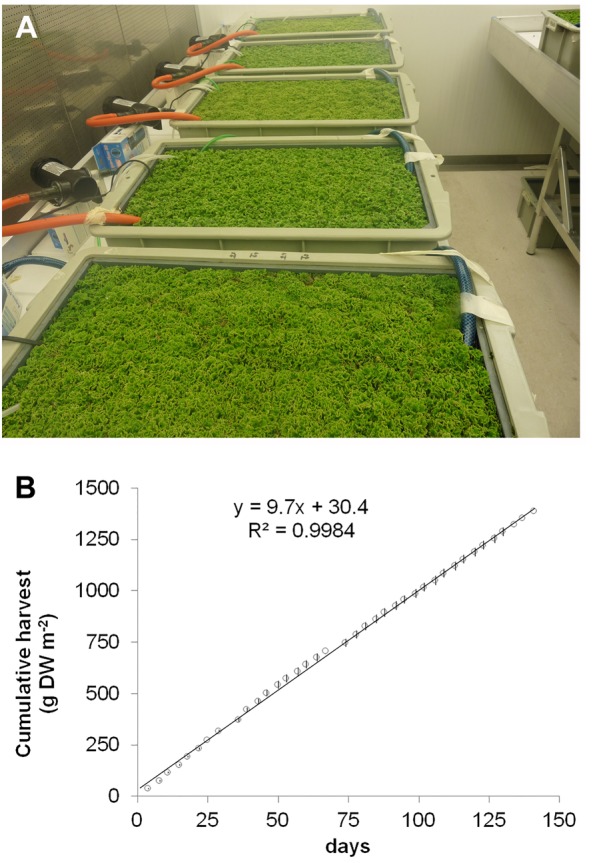
Azolla filiculoides yield potential under continuous production conditions. Ferns were grown with 300 μmol s−1 cm−2 photosynthetic active radiation at 25°C for the 12 h day and at 22°C during the 12 h night. (A) Closed-canopy cultures with plants in the linear growth phase for continuous harvest. (B) Cumulative dry biomass harvested. Once standing crop formed a closed mat at 160 g m2 dry weight, continuous harvest was at a rate of 33% of the biomass twice per week. Linear regression equation is shown along with its fit; n = 6, standard deviations were smaller than the labels.